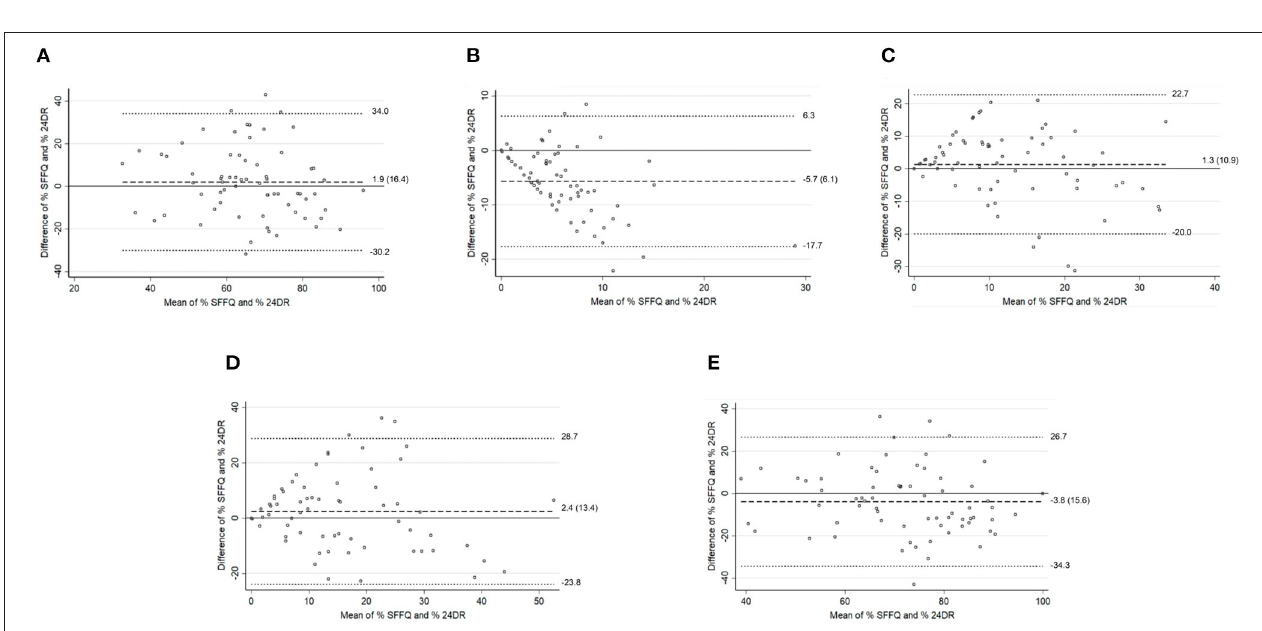
FIGURE 3 | Older adults ( ≥ 60 y). Bland–Altman plots for % energy intake between the SFFQ and 24DRs: (A) Unprocessed and minimally processed foods group. (B) Processed culinary ingredients group. (C) Processed foods group. (D) Ultra-processed foods group. (E) Unprocessed and minimally processed foods group and processed culinary ingredients group. Dotted lines represent 95% limits of agreement. Dashed line represents difference of mean.